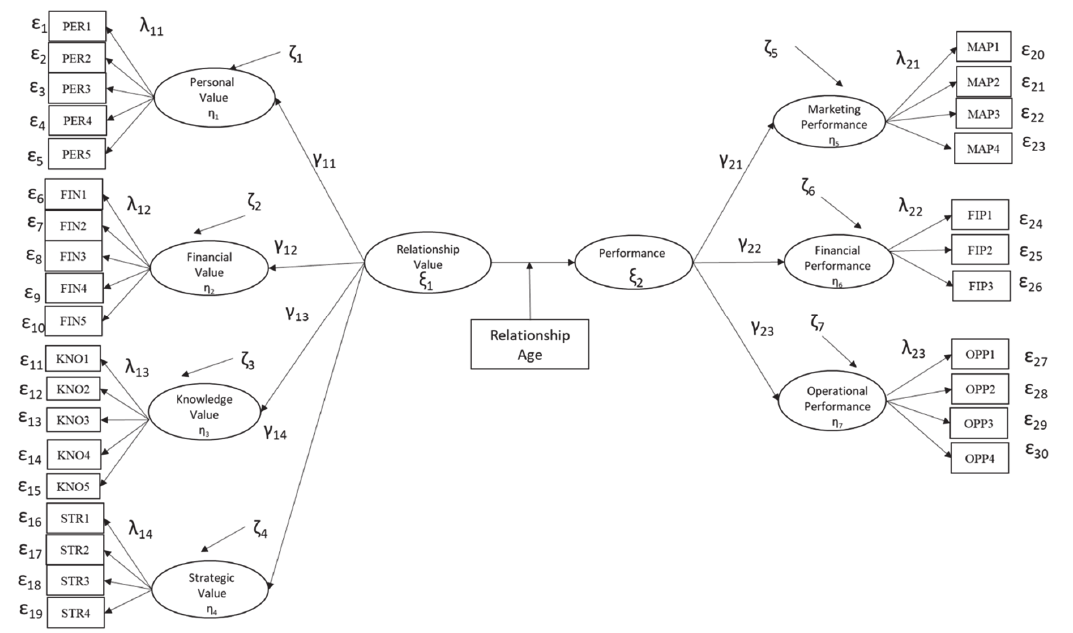
Fig. 3. The measurement model in the presence of relationship age as a moderator between relationship value and